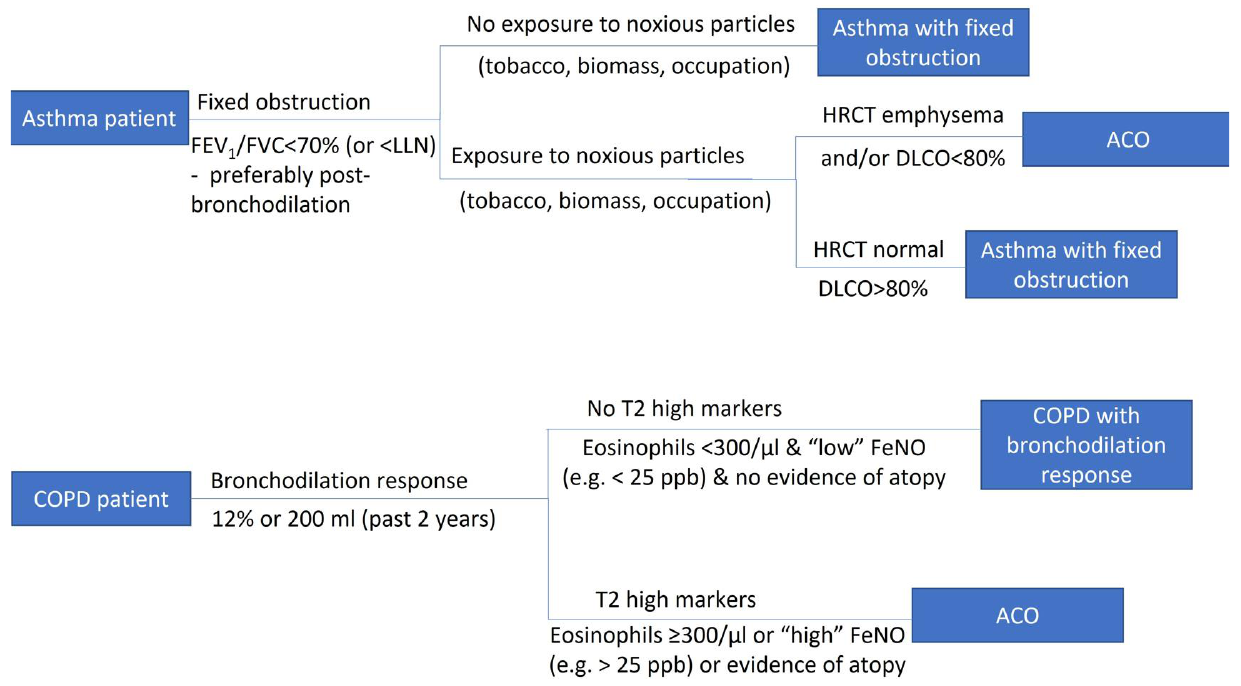
Figure 1. Diagnostic algorithm for asthmatic smokers.